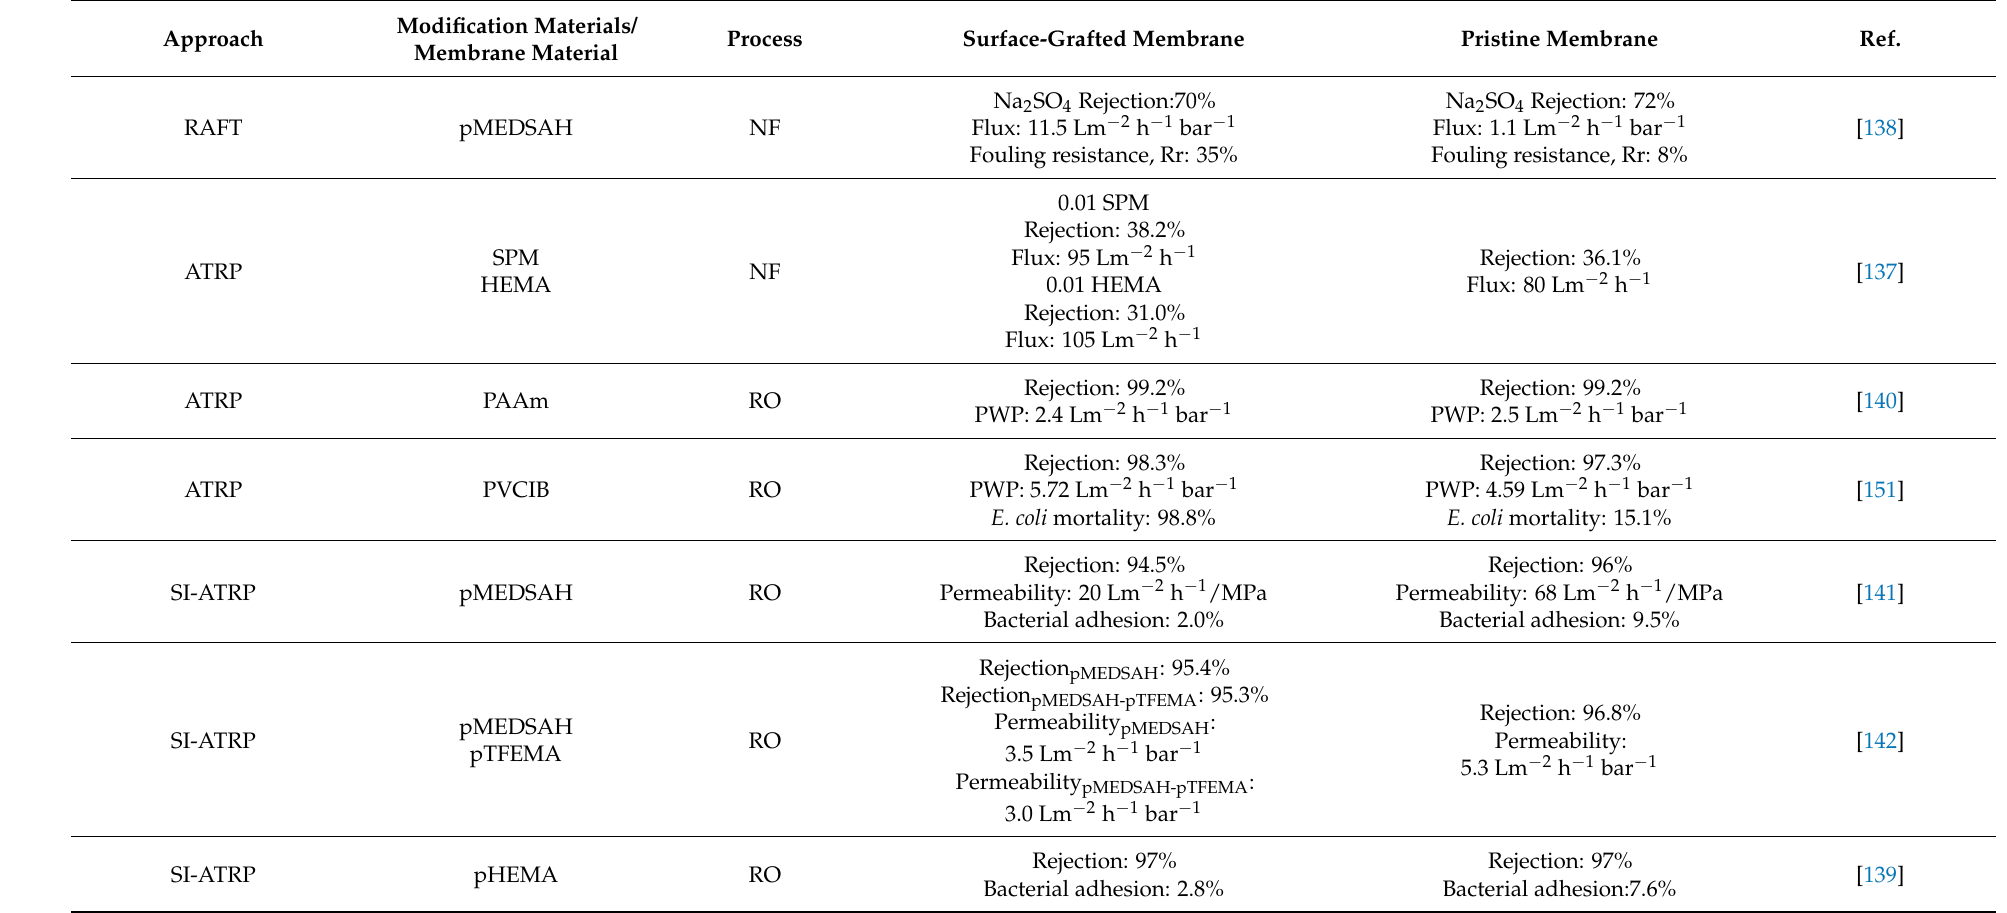
Table 3. Performance evaluation of modified and pristine PA TFC